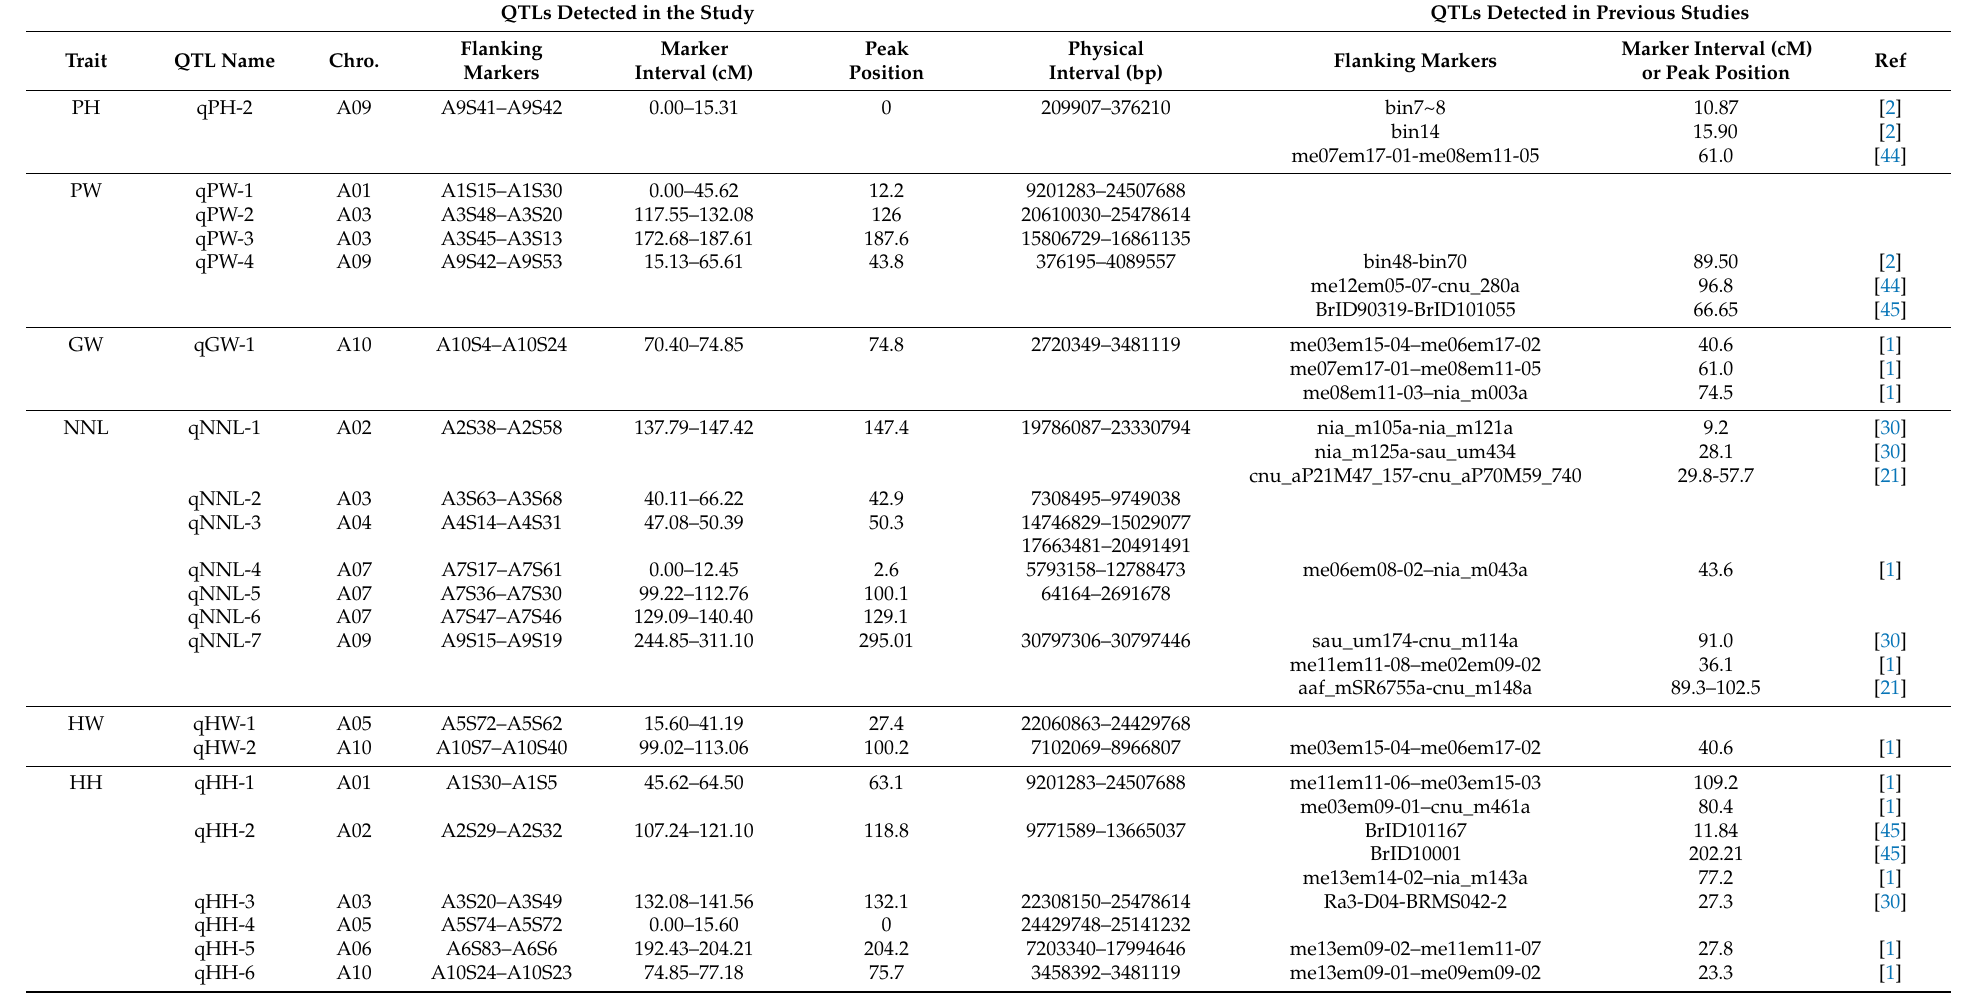
Table 5. Details of the QTLs identified for the 16 traits of Chinese